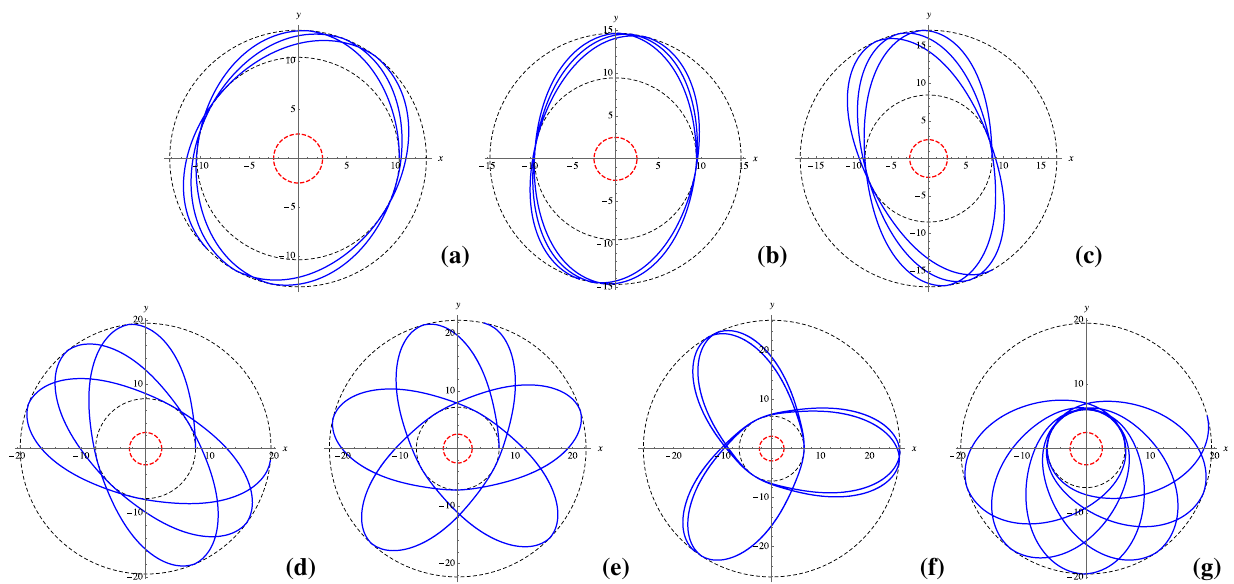
f E 2 = 0 . 718 and g E 2 = 0 . 7194. The inner and outer dashed circles indicate, respectively, r P and r A for each energy level and the small red circle is r